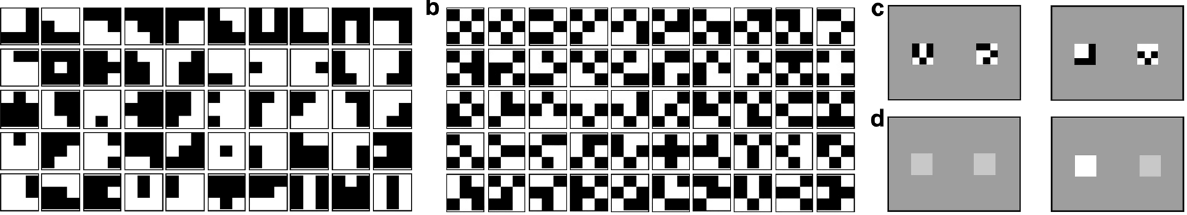
Figure 1. Stimuli and conditions. (a) Optimal features. Set of stimuli used as cues in the experimental condition of the attention tasks, considered as salient features by the reference model 13 . (b) Non-optimal features. Set of stimuli used as cues in the experimental condition of the attention tasks, considered non-salient features by the reference model 13 . On average, optimal and non-optimal features did not differ in luminance and in their spatial frequency content, between 9 and 27 cycles/deg, well above the frequency of maximum sensitivity (about 7 cycles/deg) in our illumination conditions 47 . (c) Experimental condition. Left panel:—Example of neutral trial. Two non-optimal features, considered equally non-salient by the reference model, used as baseline for the experimental condition. Right panel—Example of non-neutral trial. One optimal (left) and one non-optimal (right) feature, one more salient than the other according to the reference model. (d) Control condition. Left panel:—Neutral trial. Two cues with the same luminance contrast, considered equally salient, used as baseline for the control condition. Right panel—Example of non-neutral trial. Two cues with different luminance contrasts, one being considered more salient than the other based on their luminance. Features are shown oversized for illustration purposes. The cue stimuli and conditions used in the covert attention and gaze- orienting tasks were the